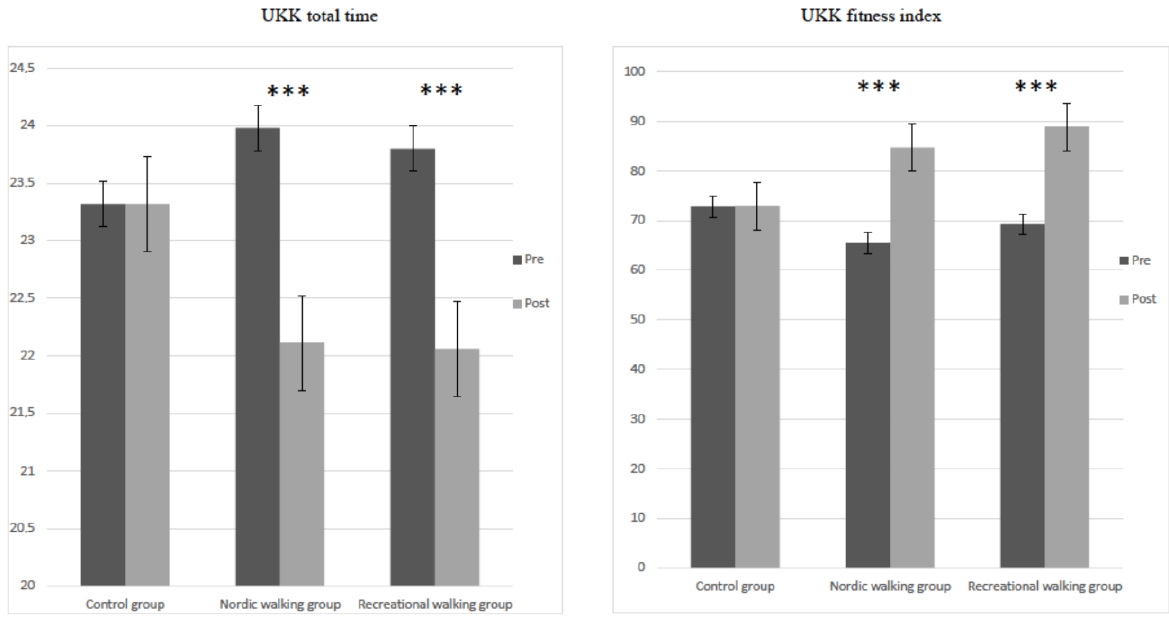
Figure 4. Differences in UKK total time and UKK fitness index in pretest and posttest interventions in the three studied groups. *** p < 0.001